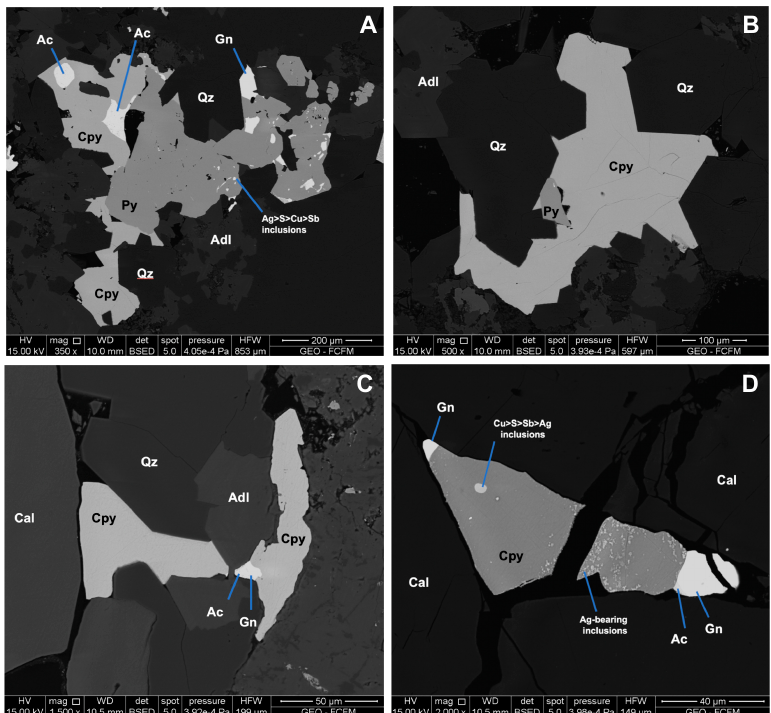
Figure 2. ( A – D ) show back-scattered electron (BSE) images of chalcopyrite from the Cerro Pabellón geothermal system. Chalcopyrite is euhedral to subhedral and is mostly free of mineral inclusions, although some grains show Ag-bearing micro-inclusions (e.g., ( D )) and larger inclusions of Cu–S–Sb–Ag-bearing minerals (e.g., ( A ) and ( D )). Abbreviations: chalcopyrite (Cpy), pyrite (Py), acanthite (Ac), galena (Gn), adularia (Adl), calcite (Cal), quartz (Qz).